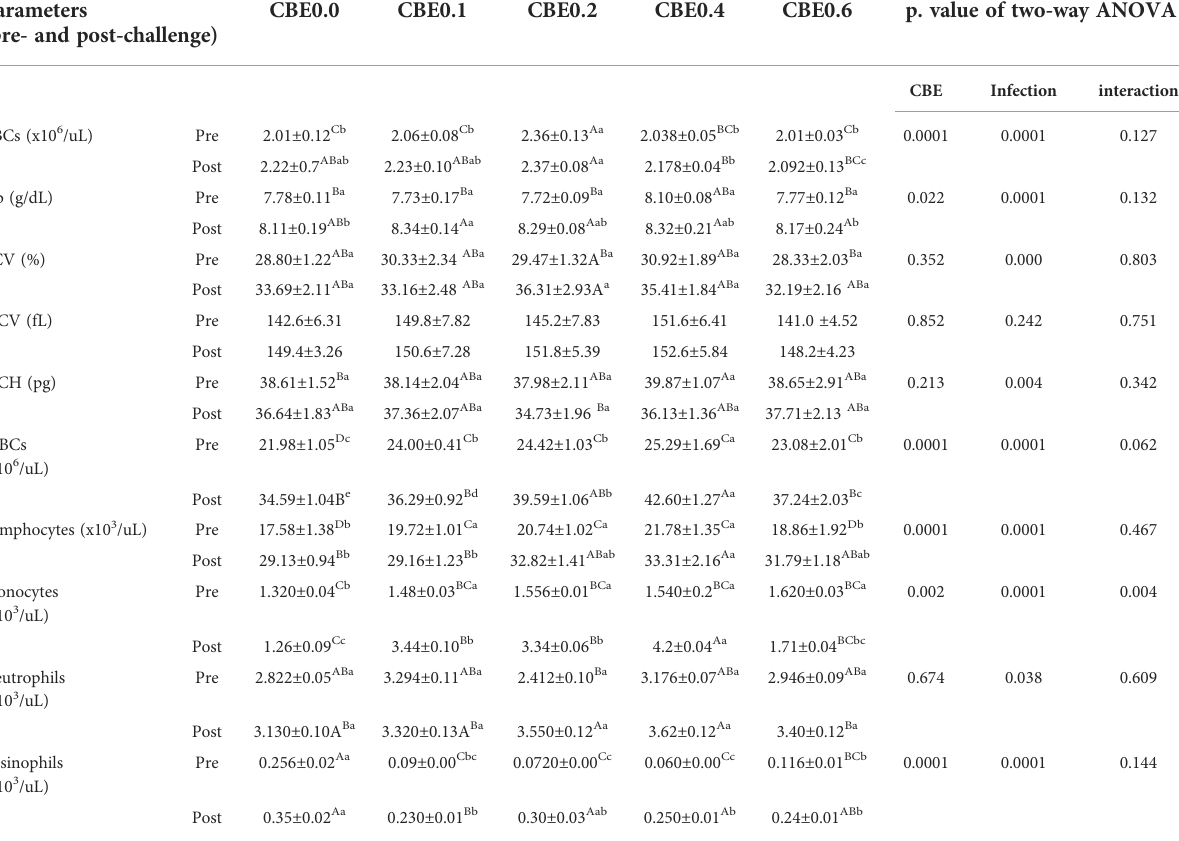
TABLE 5 Hematological parameters of Nile tilapia ( Oreochromis niloticus ) fed on different doses of CBE for 10 weeks pre- and post-challenge. Parameters (pre- and